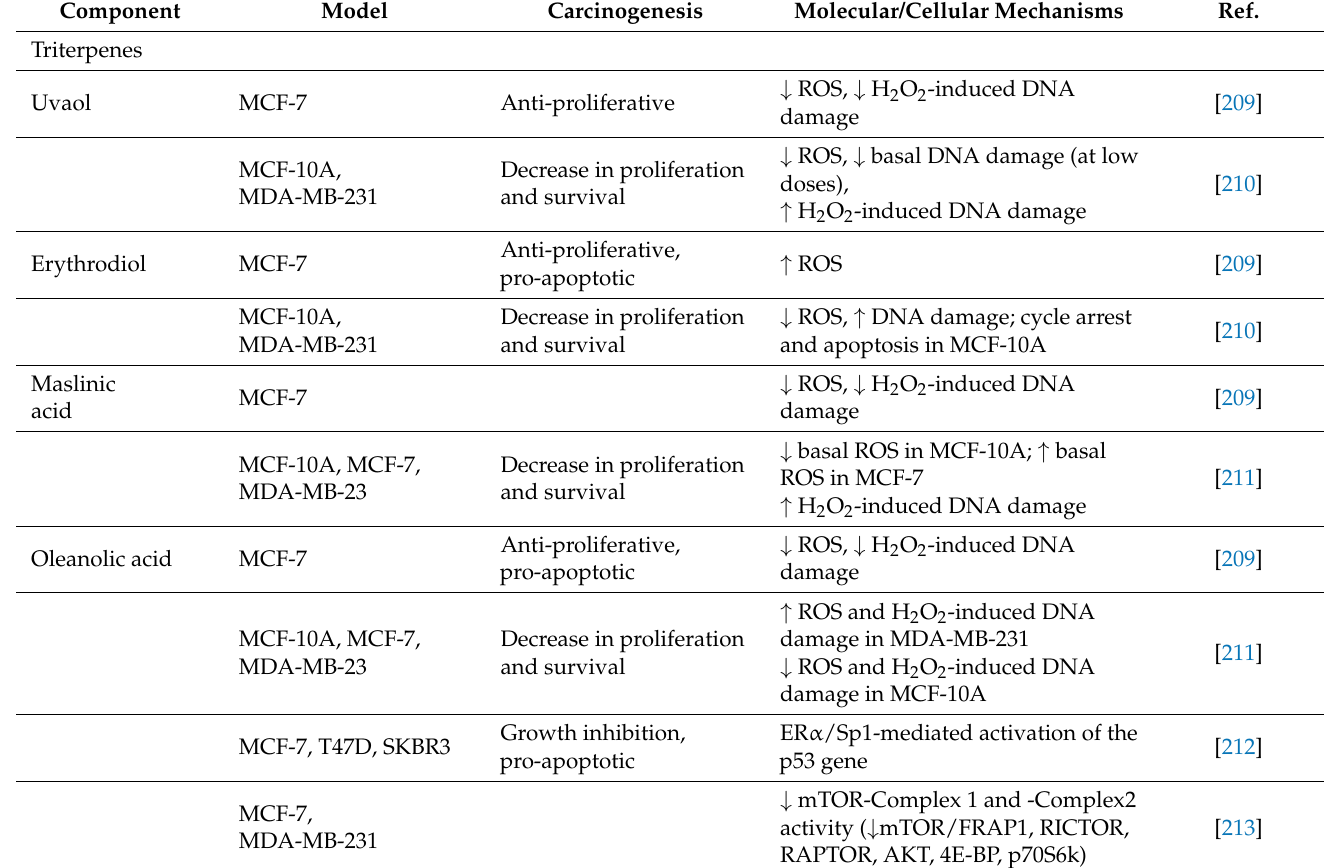
Table 3. Overview of the effects of extra-virgin olive oil minor compounds on breast carcinogenesis and associated molecular and cellular mechanisms. Mechanisms induced in combination with chemotherapeutics are not shown. Carcinogenesis Molecular/Cellular Mechanisms